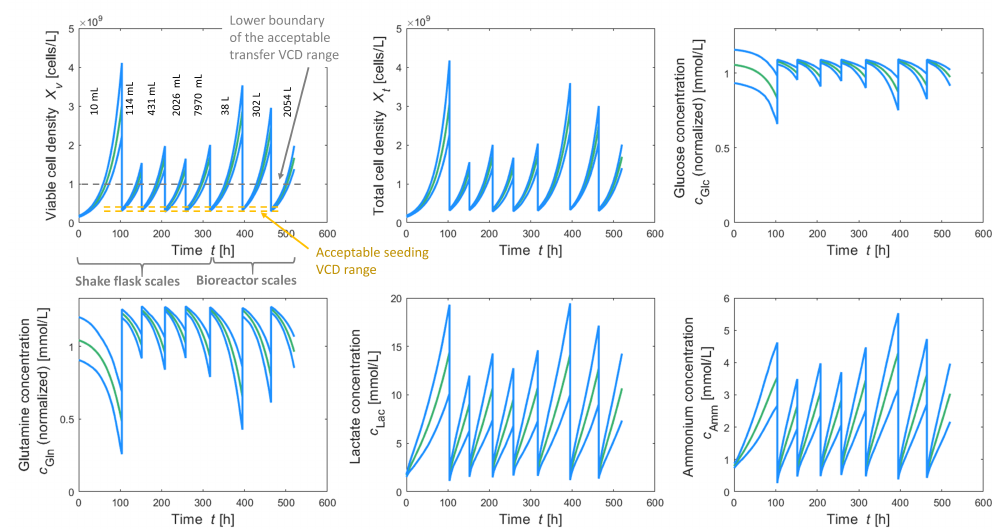
Figure 6. Seed train showing viable cell density (VCD) and total cell density, as well as substrate (glucose and glutamine) and metabolite (lactate and ammonium) concentrations over time and over the whole seed train (5 shake flask scales and three bioreactor scales), based on the shake flask filling volumes according to solution 1. The green lines represent the mean time course and the blue lines show the corresponding 90%-prediction band (5%- and 95%-quantiles). The plot (top left) also includes the filling volumes and the acceptable ranges for seeding VCD and transfer VCD, illustrated through dashed